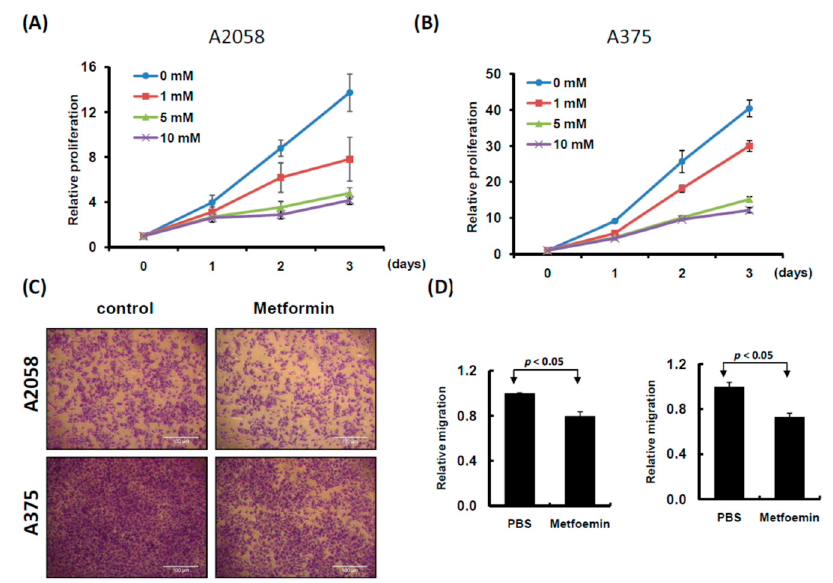
Figure 1. Proliferation and motility of melanoma cells were suppressed with metformin treatment. ( A ) A2058 cells and ( B ) A375 cells were treated with 0, 1, 5 and 10 mM metformin for three consecutive days. Cell growth was examined using CellTiter-Glo One solution assay. ( C ) and ( D ) Cell migration assay was used to examine A2058 and A375 cells treated with or without metformin (5 mM) for three days (magnification, 100×). Migrating cells were stained with crystal violet solution, and the migration abilities were quantified through measuring three different fields under a phase-contrast microscope.